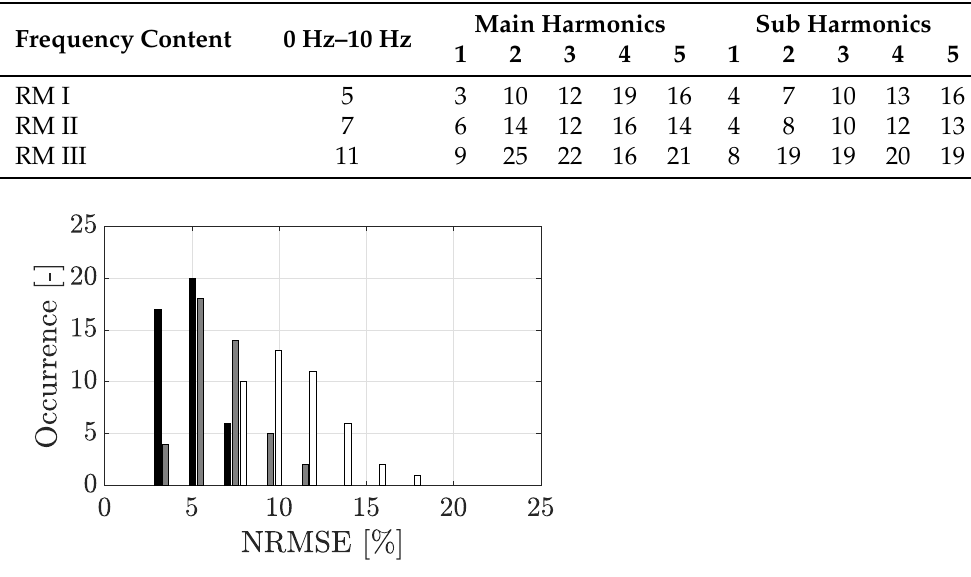
Figure 13. Histogram of the NRMSE of the reconstructed to the measured contact force using RM I (black), RM II (gray) or RM III